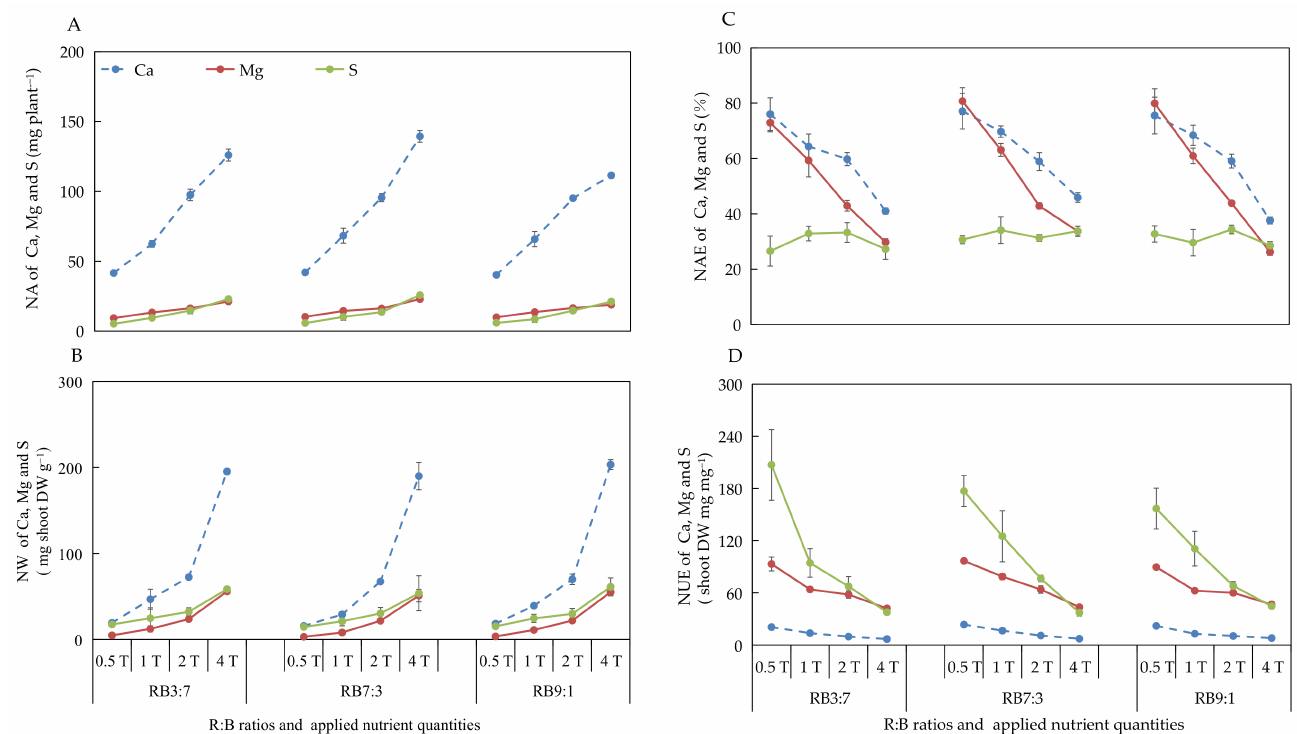
Figure 4. Nutrient absorption (NA) ( A ), nutrient waste (NW) ( B ) from producing 1 g shoot dry weight, nutrient absorb efficiency (NAE) ( C ), and nutrient use efficiency (NUE) ( D ) of shoot dry weight of Ca, Mg, and S after 20 days of cultivation under different ANQ treatments and R:B ratios. 0.5T, 1T, 2T, and 4T represent 4 different ANQ treatments. RB3:7, RB7:3, and RB9:1 represent the